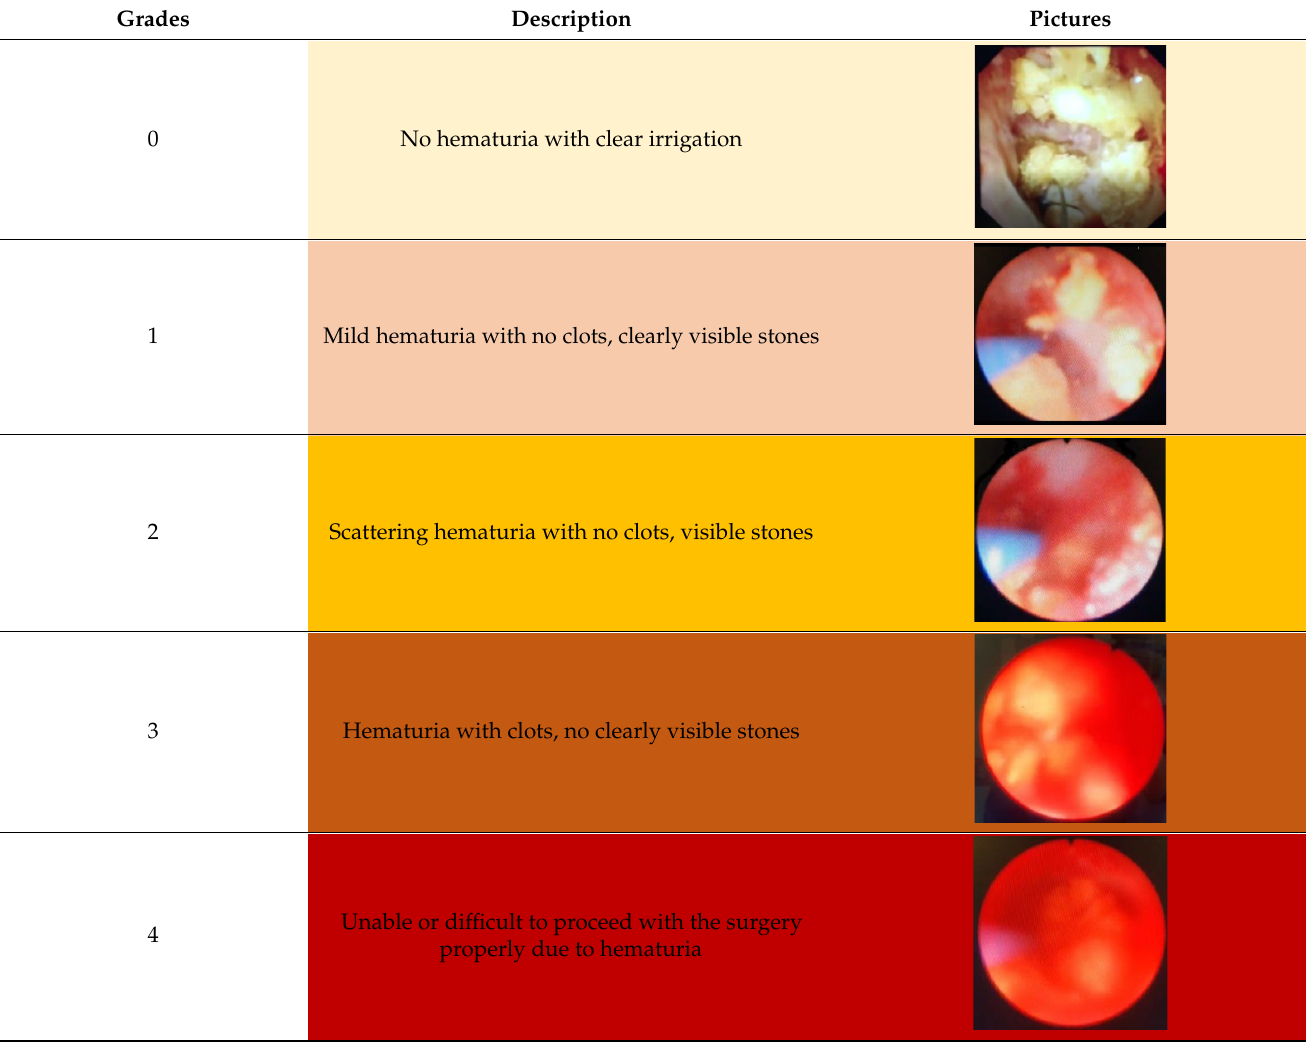
Table 1. The newly developed grade system of hematuria for stone fragmentation during flexible ureteroscopy surgery and miniaturized percutaneous nephrolithotomy.